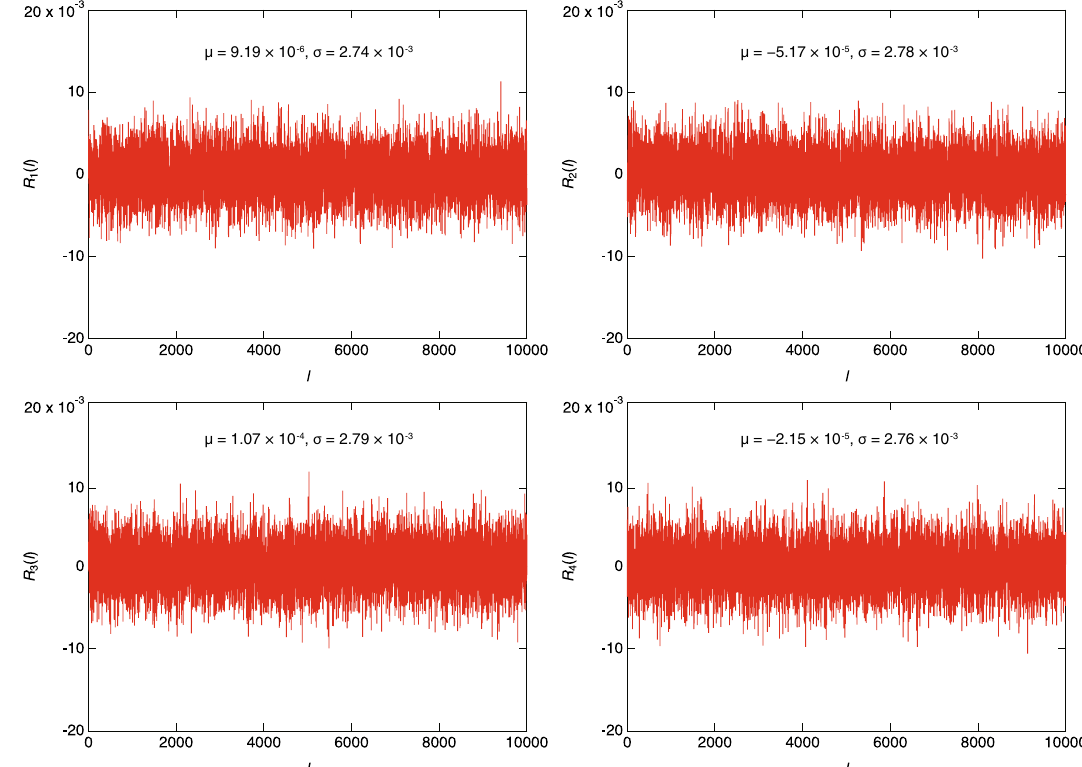
Figure 7. Measured autocorrelation functions of the bitstreams for N = 2 17 . For each autocorrelation function, the average is close to zero and the standard deviation is approximately 2.7 × 10 −3 or 2.8 × 10 −3 , which indicates that each bitstream generated by XSR does not exhibit